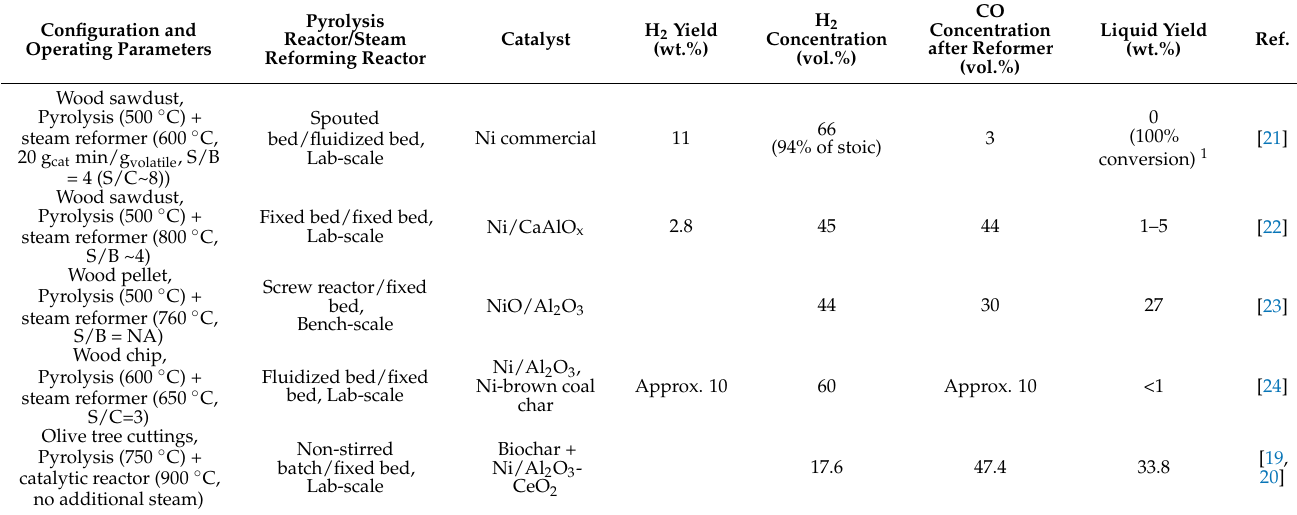
Table 1. Biomass pyrolysis with in-line reforming of pyrolysis vapor for H 2